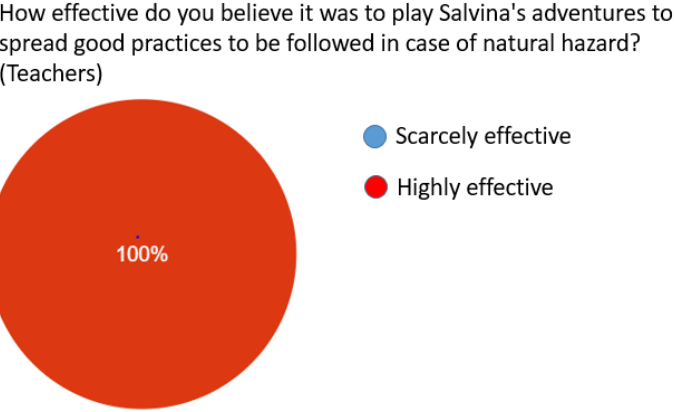
Figure 12. Pie chart showing cumulative percentage of the feedback received for the fifth question